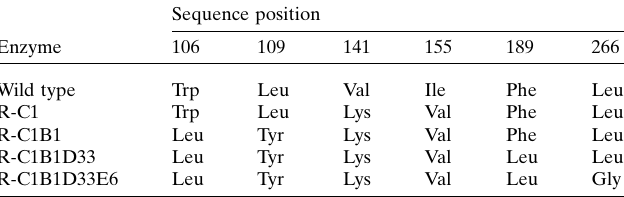
Table 2 Amino-acid sequences of StEH1 variants.